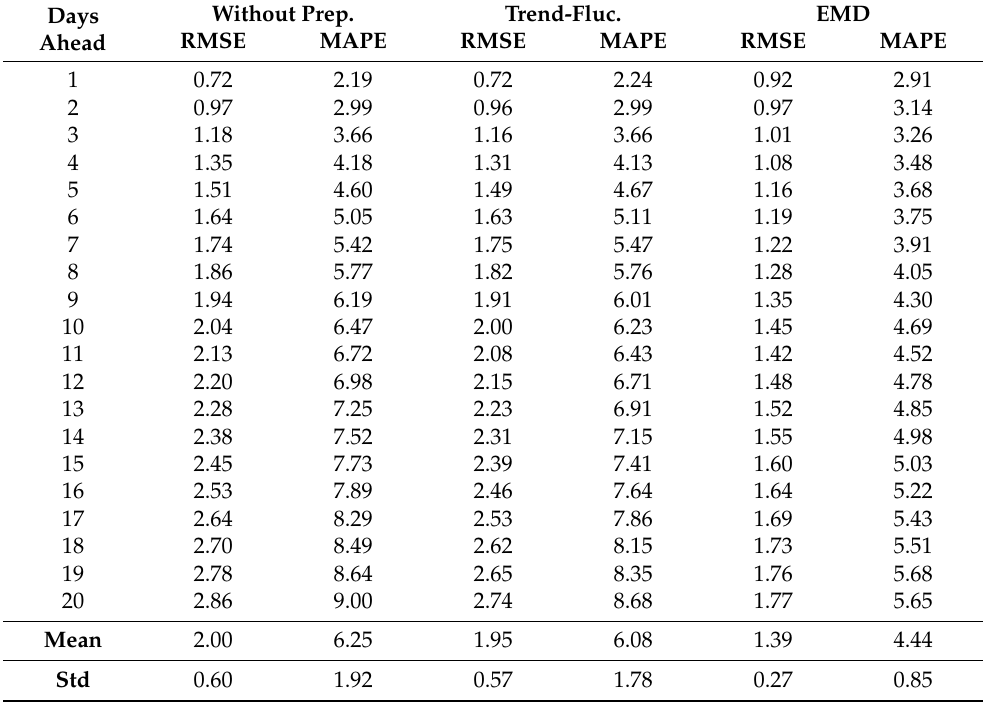
Table 4. Predictions with MLP for the whole data set (2009–2020). 80% of them were used for training and 20% for validation. Data have been scaled with standardization for “Without Prep.” and “Trend-Fluc.” and with Min-Max for